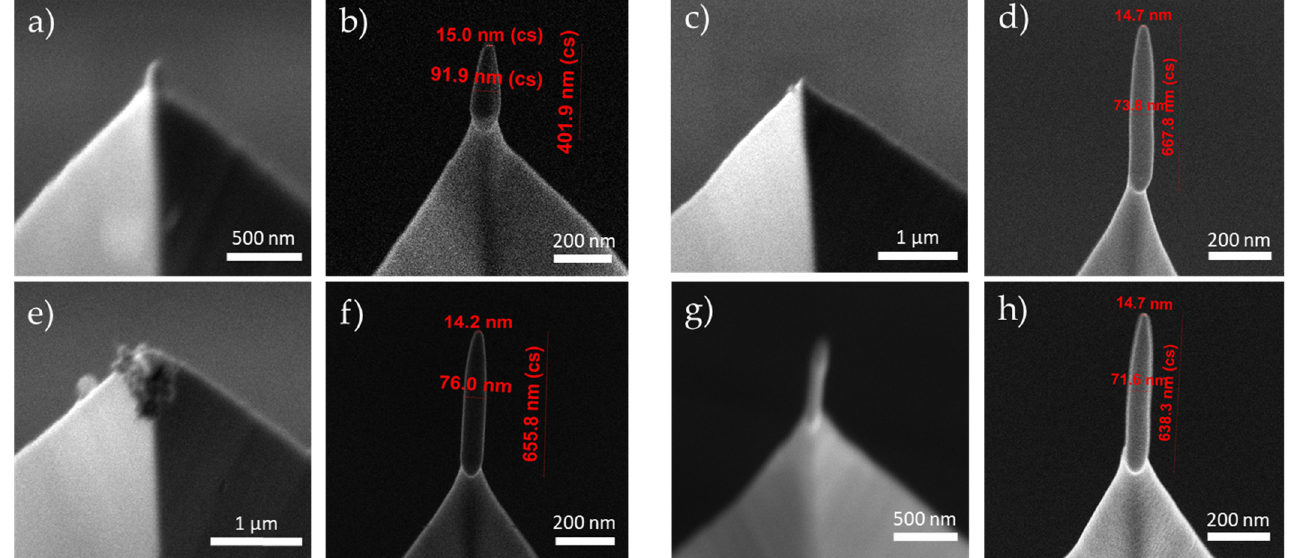
Figure 6. SEM images of FEBID Fe-based magnetic probes after ( a , c , e , g ) and before ( b , d , f , h ) the durability tests: ( a , b ) tip 1, ( c , d ) tip 5, ( e , f ) tip 7, and ( g , h ) tip 10. After 21 weeks it is observed that tip 1 and tip 10 are still on the top of the Akiyama probe, while tip 5 and tip 7 are no longer in the upper part of the Akiyama probe.